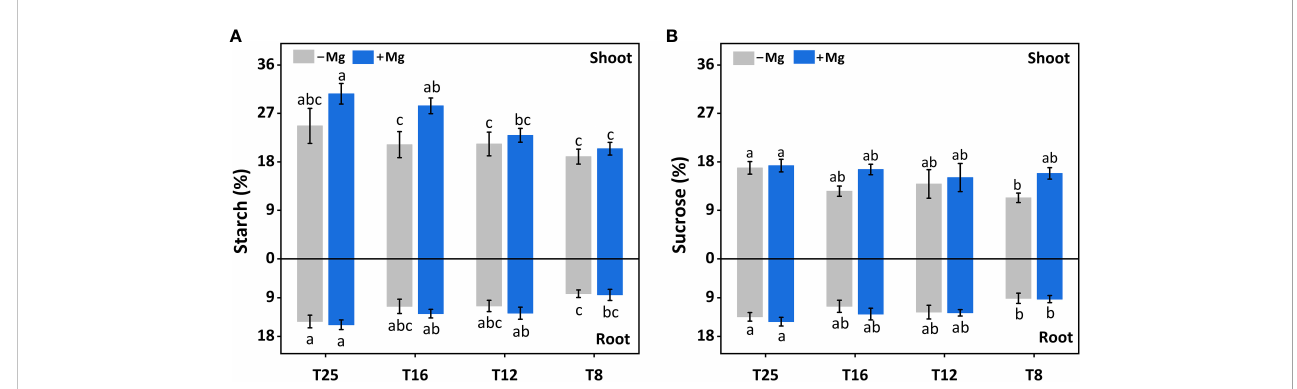
TABLE 4 Results of Two-way ANOVAs on tobacco chlorophyll parameters. Treatment Magnesium Temperature Magnesium × Temperature Chlorophyll a * * * Chlorophyll b Total chlorophyll Carotenoid The steric symbol (*) represents the signi fi cance at P< 0.05, and ns denotes the non-signi fi cant difference.